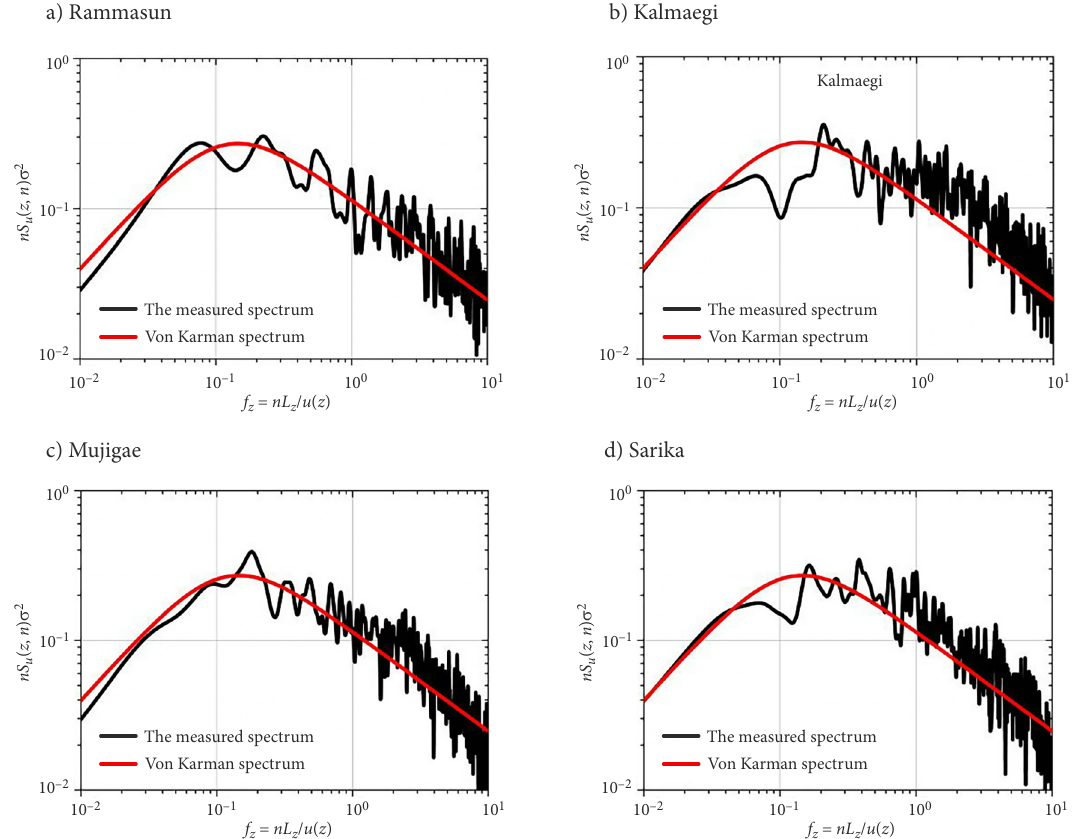
Figure 4. Measured fluctuation wind speed spectrum and Von Karmam spectrum on along-wind